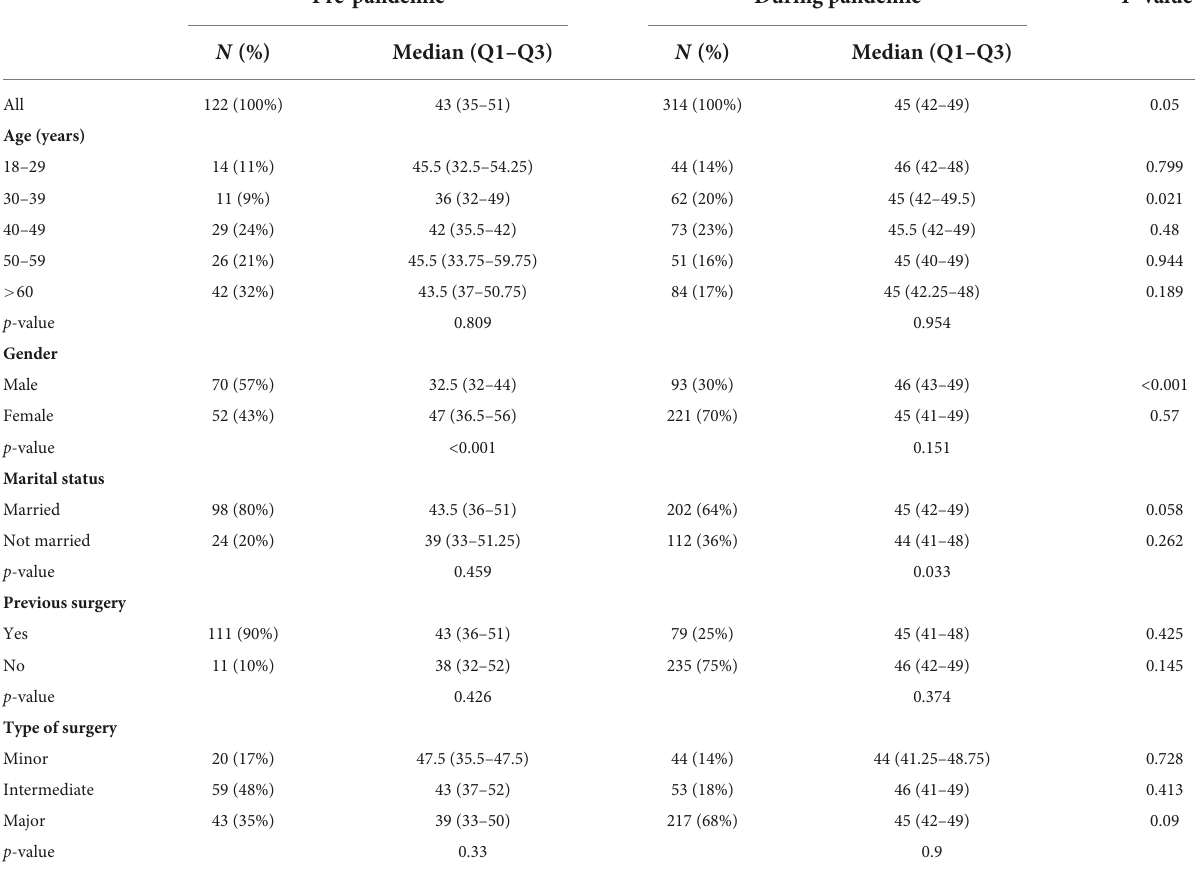
TABLE 2 STAY-Y1 score for pre-pandemic and during-pandemic groups. Pre-pandemic During pandemic